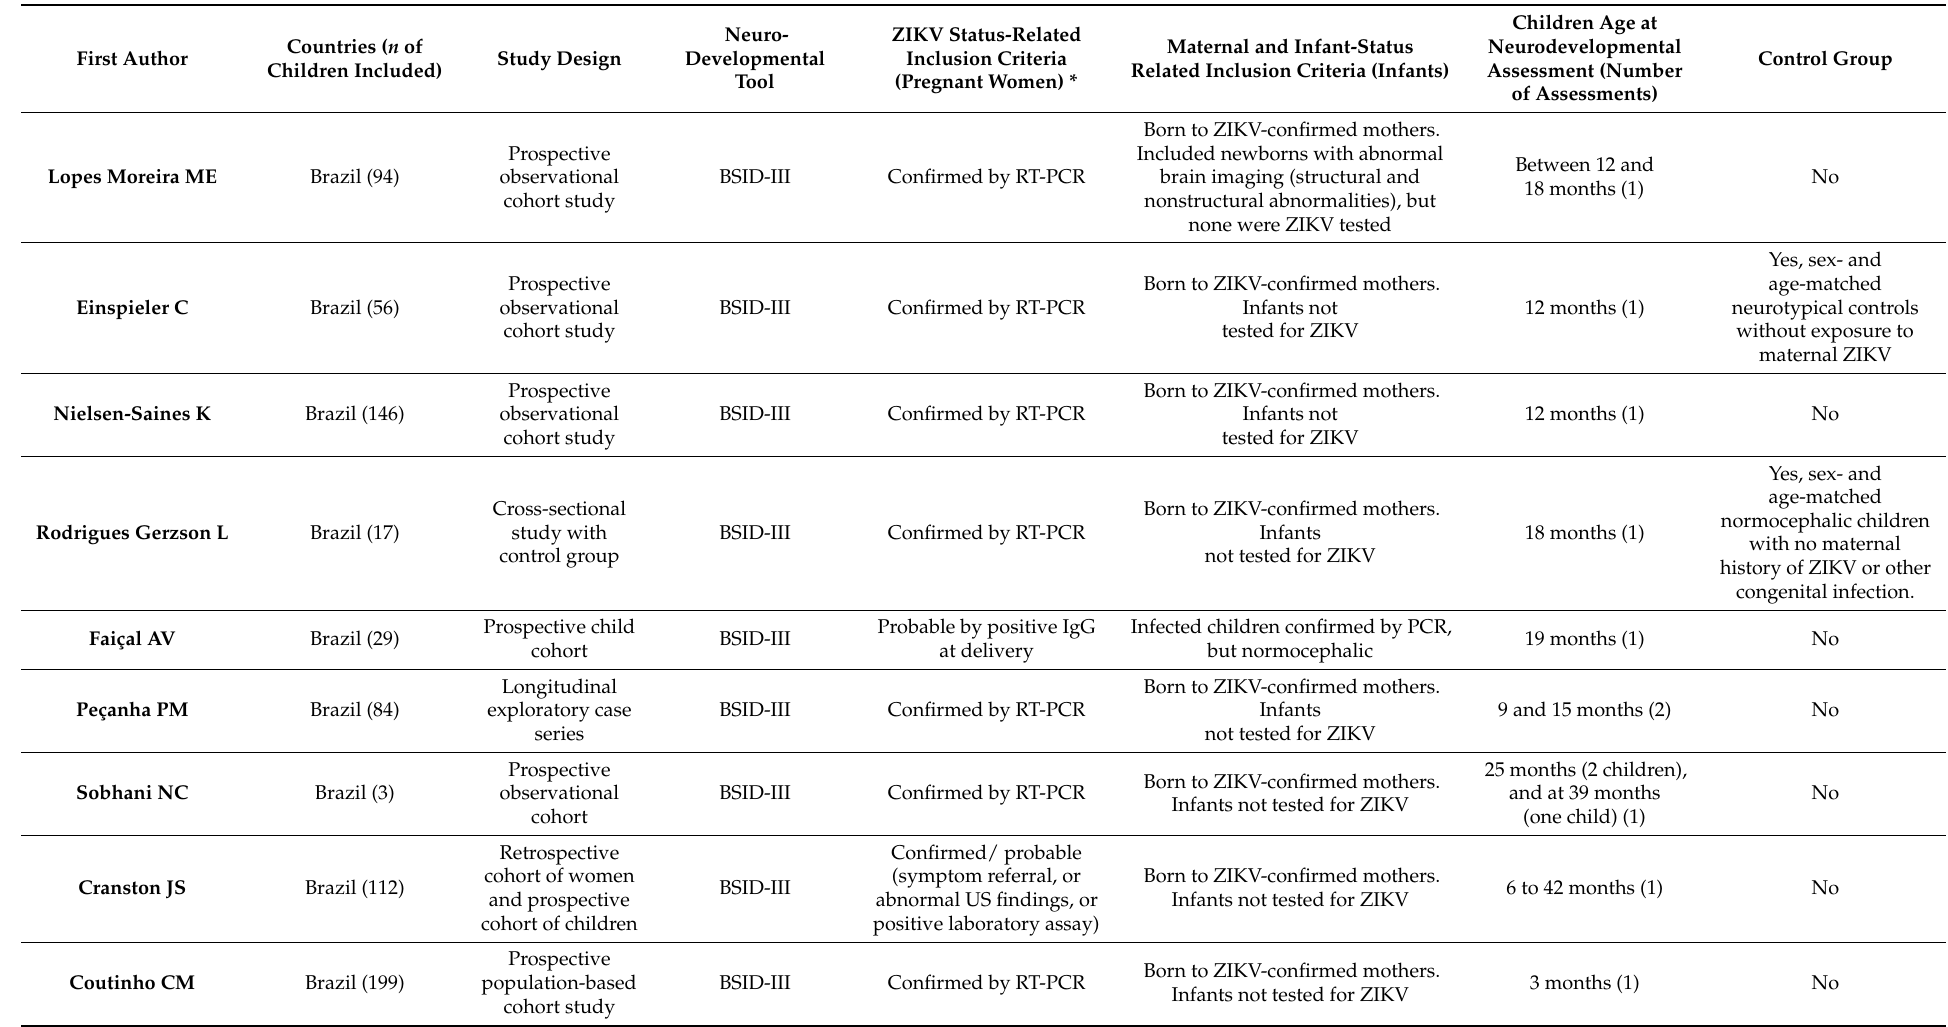
Table 1. Characteristics of studies included in the systematic